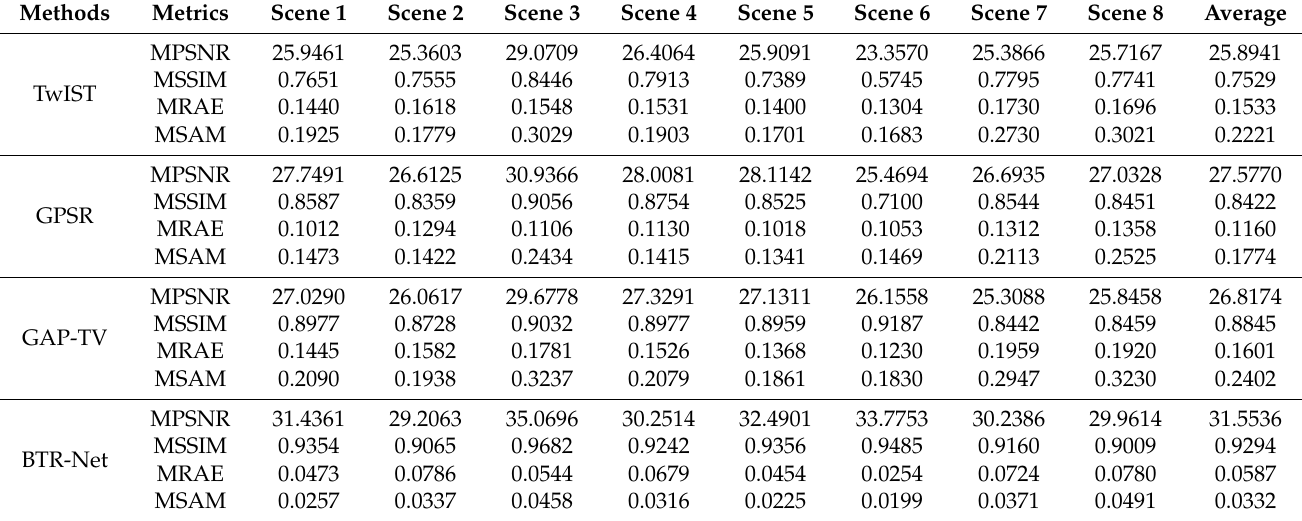
Table 1. Comparisons of reconstructed quality of BTR-Net and iterative algorithms. Each HS image is with a spatial resolution of 1280 × 1280 and 196 spectral bands. We adopted mean peak signal to noise ratio (MPSNR), mean structural similarity index measure (MSSIM), mean relative absolute error (MRAE), and mean spectral angle mapper (MSAM) as evaluation metrics.